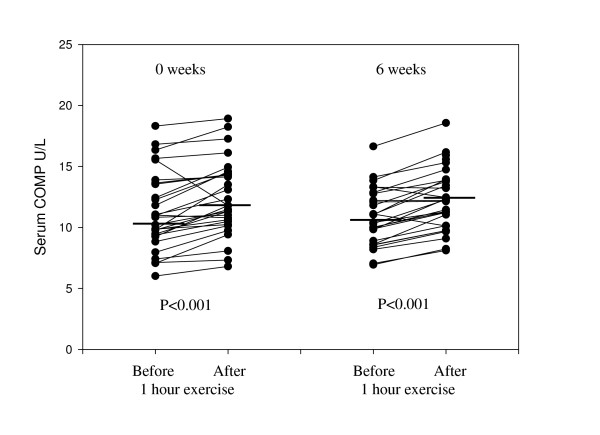
Serum COMP during intervention. Serum concentrations of COMP at weeks 0 and 6 in the exercise group in study 1. Each line represents an individual patient. Horizontal bars show median values for each sampling occasion.